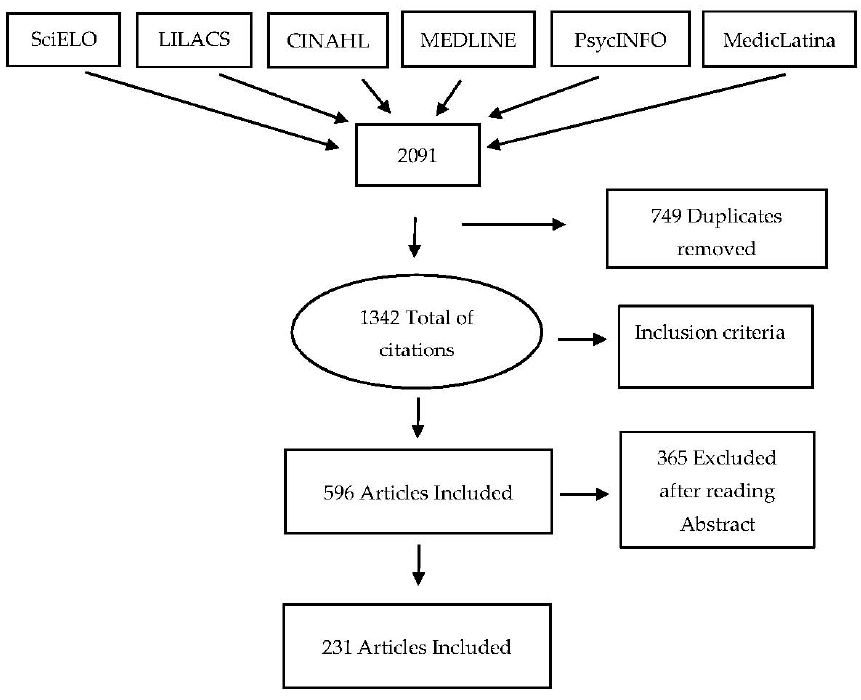
Figure 1. Study selection process.